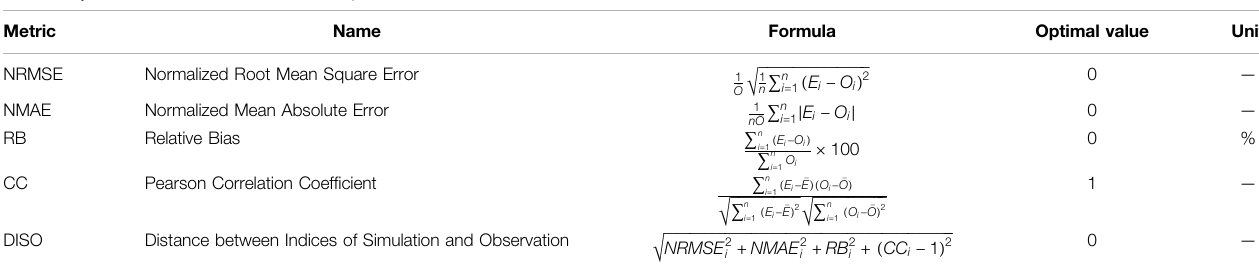
TABLE 4 | Evaluation criteria used in this